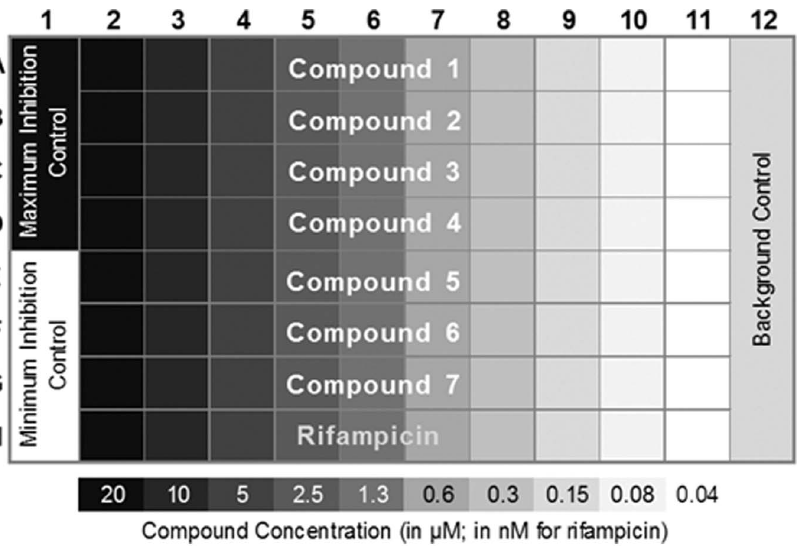
Figure 1. Final assay plate layout. The plate format is shown. Column 1 contains maximum inhibition control (rifampicin) in Rows A–D and minimum inhibition control (no compound) in Rows E–H. Column 12 is not inoculated with cells. Compounds are tested across each Row A–G in a two-fold serial dilution starting at 20 m M – concentrations are indicated below. A rifampicin dilution series is included in Row H starting at 20 nM.